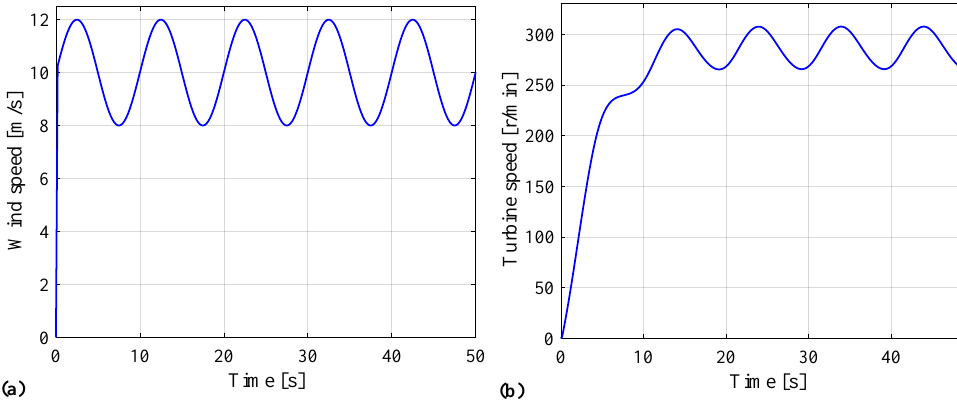
Figure 14. ( a ) Wind speed input of 0.1 Hz and ( b ) turbine speed response versus time.